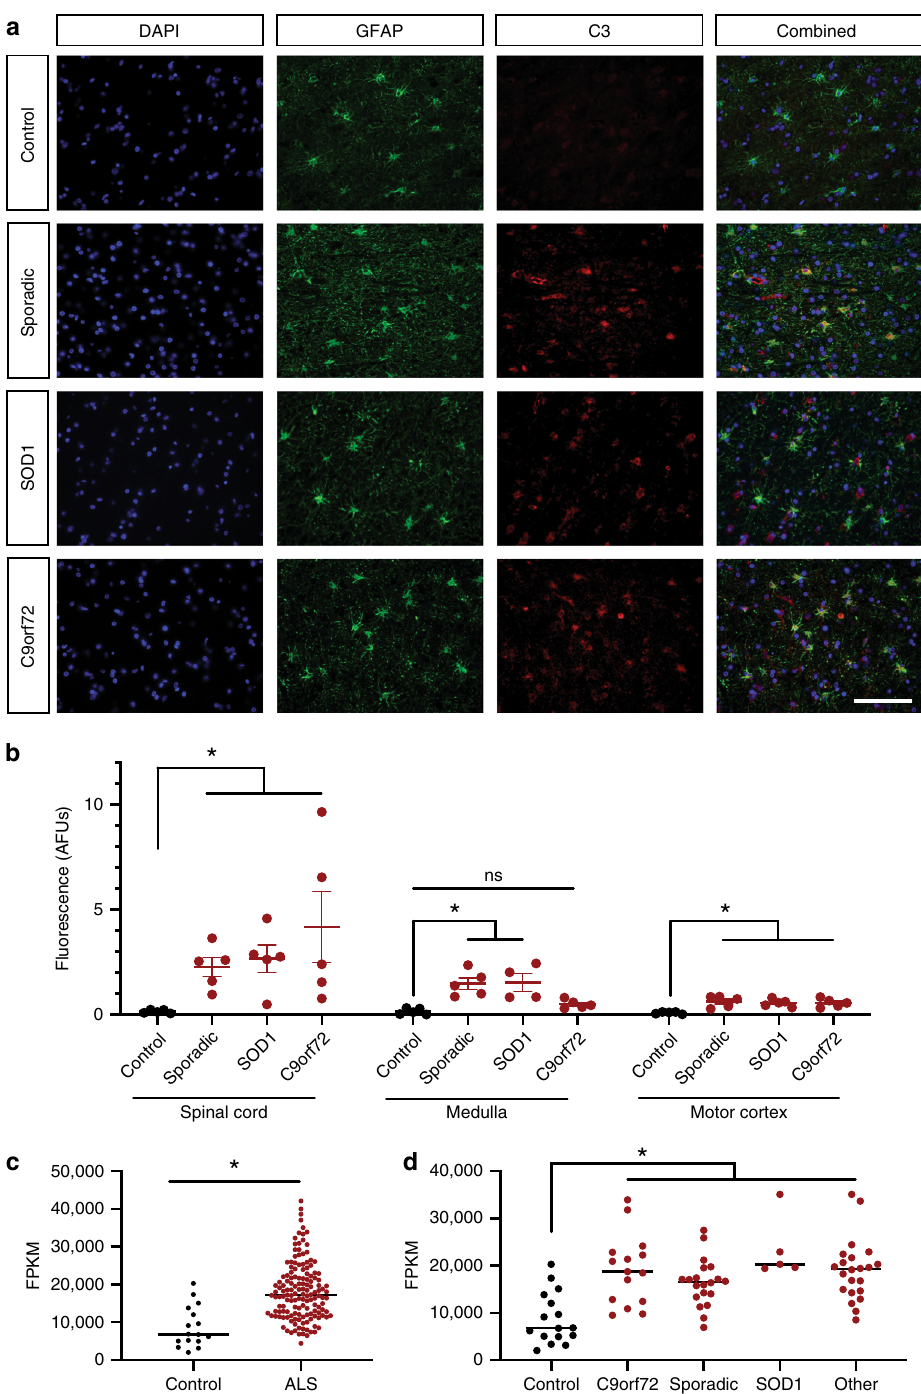
Fig. 3 Neuroin fl ammatory astrogliosis is a common pathology in human ALS. a Example images of cortical samples from patients with sporadic, SOD1, and C9orf72 associated ALS as well as nonneurological controls stained with DAPI for nuclei, GFAP for astrocytes, and C3 as a marker for neuroin fl ammatory astrocyte activation. (quanti fi ed in b ; scale bar = 100 µ m) b Quanti fi cation of C3 immunoreactivity within GFAP + astrocytes in the spinal cord, medulla, and cortex. There was signi fi cantly more C3 staining within astrocytes in all subtypes of ALS compared to controls in the spinal cord, medulla, and cortex except for samples of the medulla from C9orf72 associated ALS patients. (* p <0.05 by Kruskal – Wallis nonparametric test corrected for multiple comparisons using the Dunn method; mean ±s.e.m.) c Bulk RNA-seq C3 expression from the spinal cord of ALS patients vs control (* p <0.05 by unpaired, two-tailed Student ’ s t test; mean). d Subsampling of data in c by identi fi ed ALS subtype (other = other genetic cause; * p <0.05; two-tailed, unpaired Student ’ s t test, corrected by Dunnett method; RNAscope in situ hybridization and quanti fi cation . RNAscope fl uorescent Multiplex RNAscope was performed according to manufacturer ’ s protocol against the targets C3 , Aldh1l1 , Slc1a3 , and Cx3cr1 . In order to achieve complete in situ hybridization was performed on fresh-frozen tissue. After sacri fi ce, brains and robust labeling of astrocytes, we imaged probes against both astrocyte were removed by dissection and spinal cords were removed by hydraulic markers Aldh1l1 and Slc1a3 in the same channel, denoted by Aldh1l1 + Slc1a3 in extrusion into ice-cold PBS. Tissue was embedded in OCT compound (Tissue- Fig. 1 and Supplementary Fig. 1. Tek) and 14 μ m tissue sections were prepared and immediately frozen at − 80 °C.